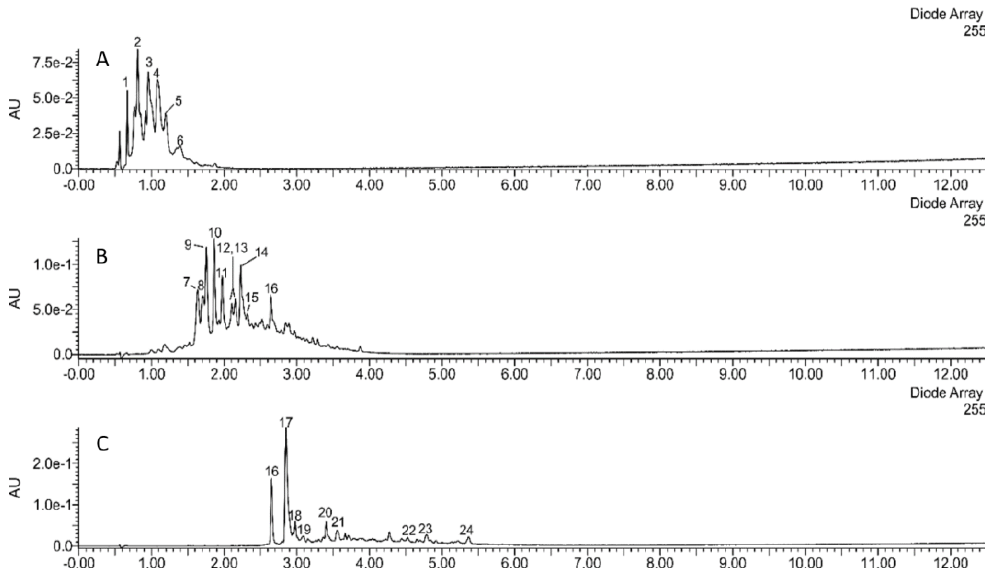
Figure 2. UHPLC-UV chromatogram of preparations ( A – C ), made from the extract of sea buckthorn twigs. Major peaks: